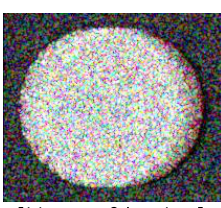
Figure 2: Pauli image of the simulated SAR data The calculated images of 𝜑 𝑣 and 𝜑 0 in the simulated data are presented in Figure 3.